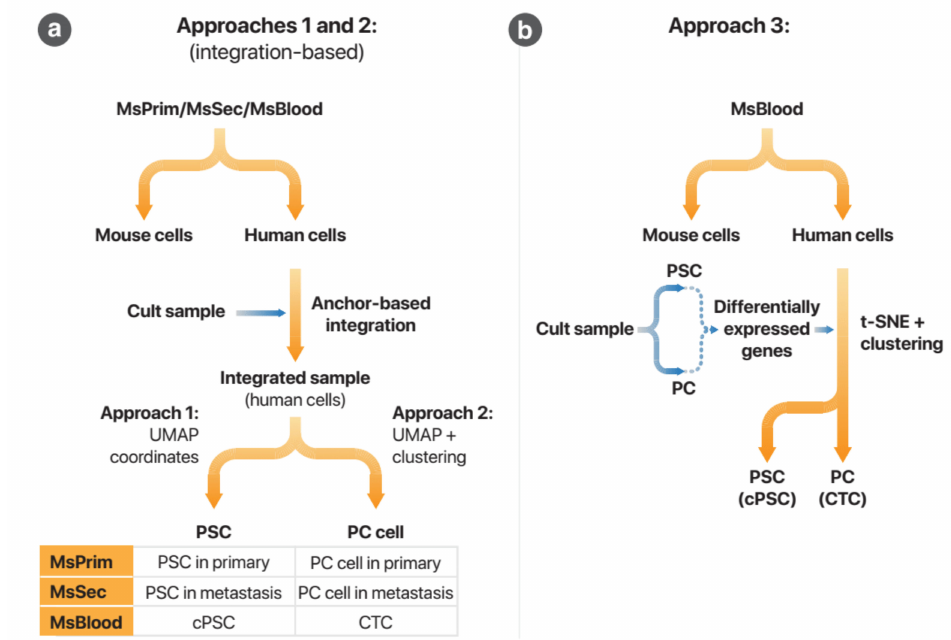
Figure A5. Different approaches to cPSC identification. These flow charts summarise the three different approaches used for cPSC identification. ( a ) Approaches 1 and 2 relies on an anchor-based integration technique to combine the human cells of the three mouse model samples with the human cultured cell samples. Cell identification was then performed either according to UMAP coordinates (Approach 1) or by unsupervised clustering (Approach 2). ( b ) Approach 3 avoids integration of samples altogether. First, the cultured cell sample was used to derive a list of 1000 differentially expressed genes between PC cells and PSCs (top 500 markers for each cell type). These genes were then used to classify the MsBlood human cells into either PC cells (CTCs) or PSCs (cPSCs) by unsupervised